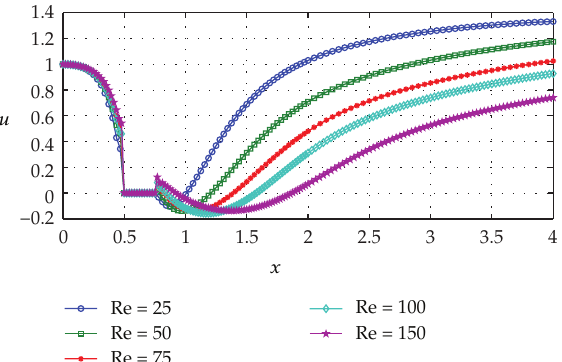
Figure 5: Comparison of velocity u along horizontal lines through geometric center of flow field.